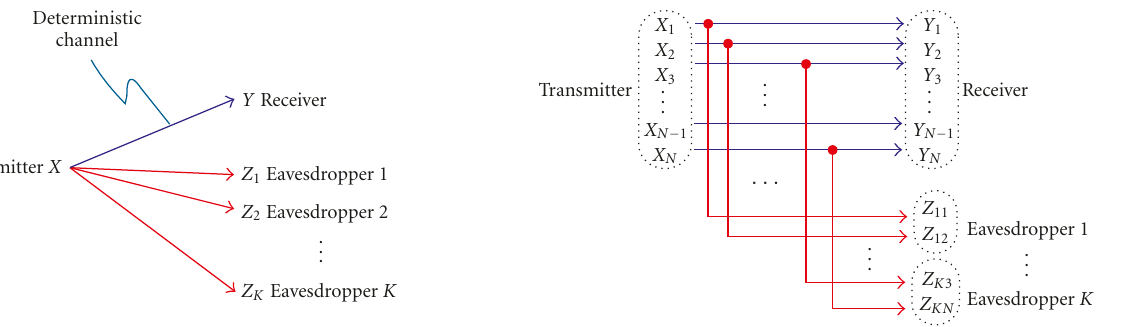
Figure 3: Parallel compound wiretap channel with one receiver and K